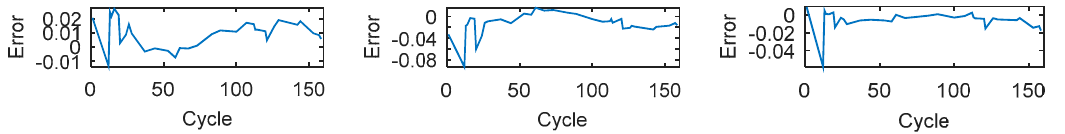
Figure 7. The SOH estimation error of the LS-SVM model with the linear kernel tested on the No.5, No.6 and No.7 batteries.